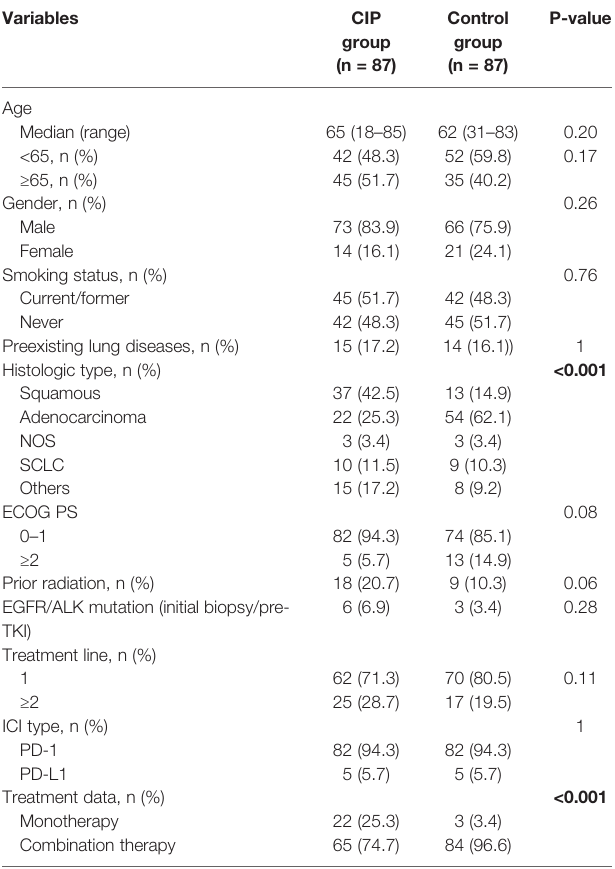
TABLE 1 | Baseline characteristics in advanced lung cancer patients treated with ICIs.